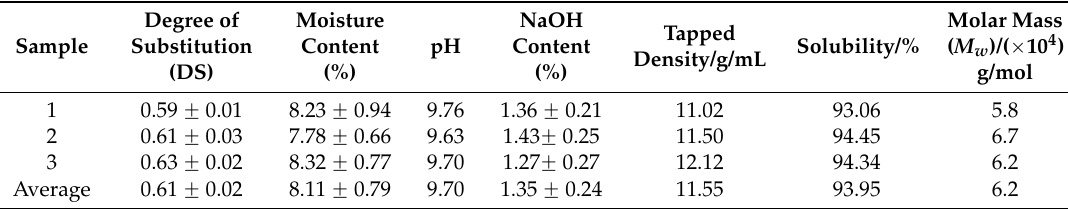
Table 4. Characterization of physical and chemical properties of CMSC (carboxymethyl sago cellulose).